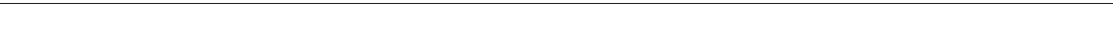
Fig. 6 TMEM106B induces lysosomal exocytosis. a 393P cells with inducible expression of GFP-TMEM106B or GFP alone were transfected with an RFP- LAMP1 construct. After induction for 24 – 48 h, cells were counter stained with Hoechst33342. Live cells were imaged in real time. Indicated scale bar = 5 µ m. b Western blot analysis upon subcellular fractionation of cells with induction of GFP-TMEM106B or GFP control. c Immuno fl uorescence staining for endogenous LAMP1 on outer plasma membrane of cells. 344SQ cells induced for either GFP only as control or GFP-tagged TMEM106B were fi rst fi xed using paraformaldehyde followed by immune staining using a phycoerythrin (PE)-conjugated LAMP1 primary antibody, without permeabilization, to speci fi cally stain the endogenous LAMP1 present on the cell surface. d Western blot analysis for secreted lysosomal proteins in the conditioned media of cells expressing GFP-TMEM106B or GFP. e Cathepsin B activity measured using speci fi c activity assay, in 50 µ l of conditioned media from cells with either TMEM106B induction or knockdown, as indicated. f Cathepsin D activity measured using speci fi c activity assay, in 50 µ l of conditioned media from cells with induction or knockdown of TMEM106B expression, as indicated. g Invasion of non-invasive 393P cells when suspended in conditioned media from cells induced for GFP control or TMEM106B. All asterisks indicate statistical signi fi cance by t test ( n ≥ 3, * p ≤